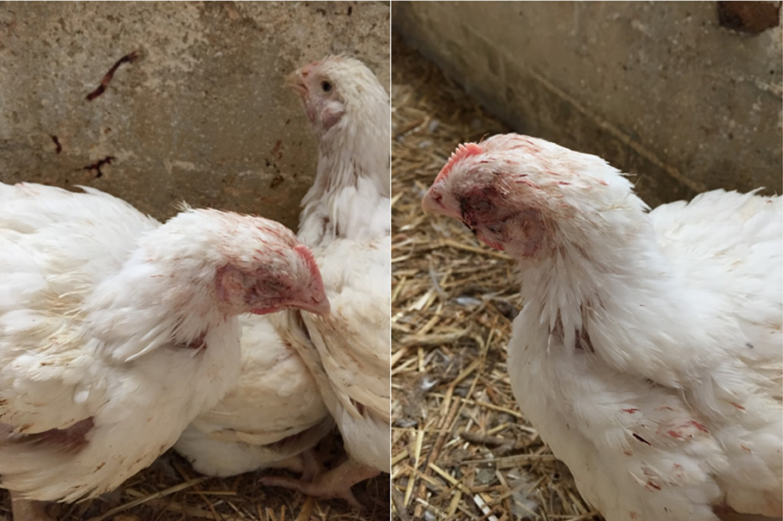
Figure 1. A 33-day-old broiler chicken with typical symptoms of ILT. In particular, bloody mucoid ocular exudate which soiled both the plumage ( right ) and the walls of the poultry house ( left